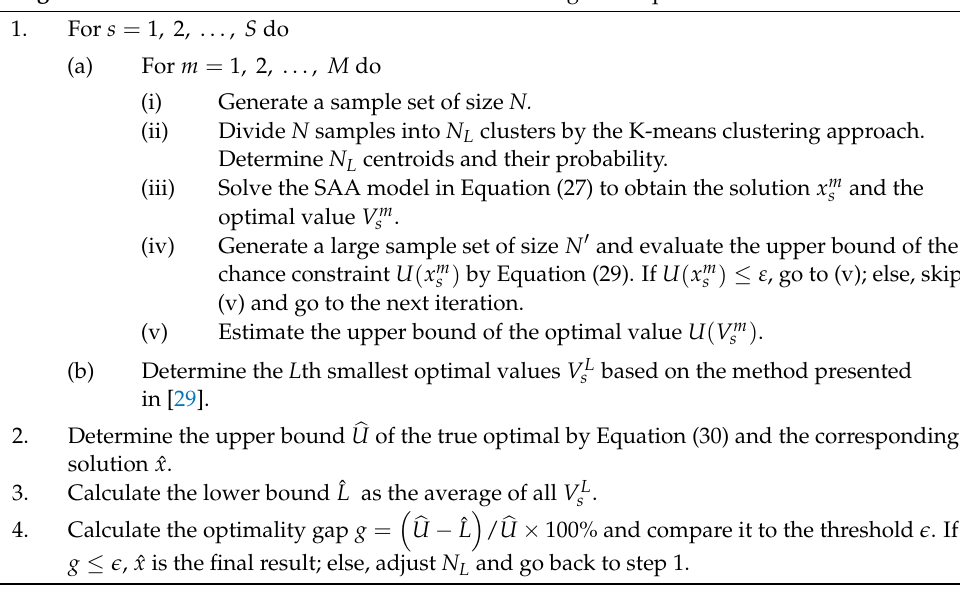
Algorithm 1 . SAA method combined K-means clustering